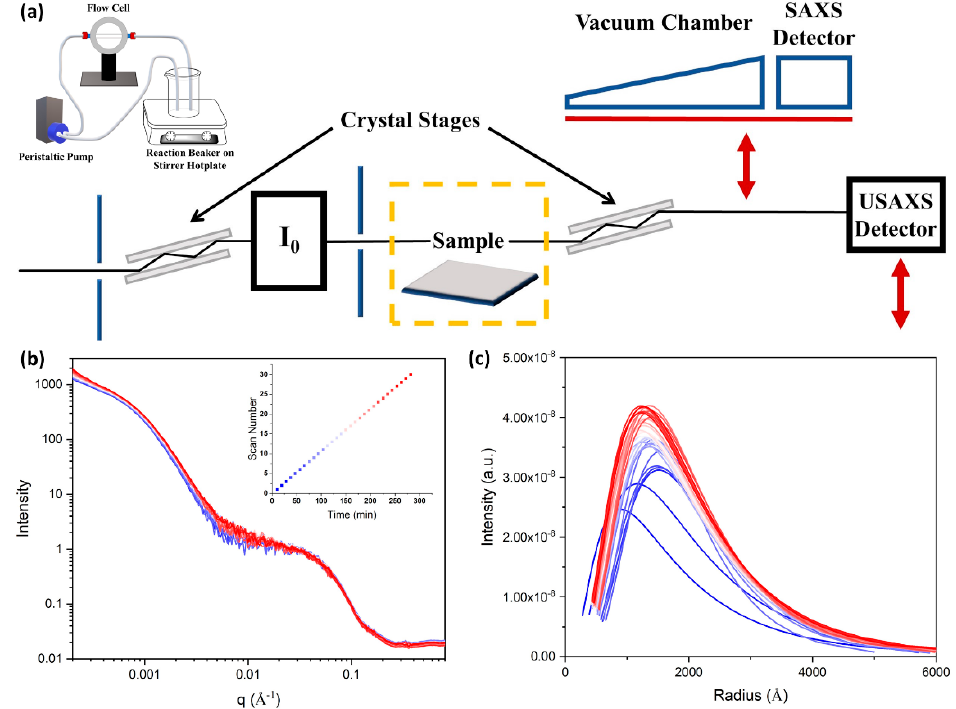
Figure 2. ( a ) Representation of the in situ experimental setup for the flow cell. The red arrows indicate the vertical motion path of the SAXS vacuum chamber and detectors. Blue vertical lines represent beam slits as part of the beamline optics. Black arrows indicate the two crystal stages used for the Bonse-Hart X-ray optics configuration. ( b ) Combined USAXS/SAXS CSNP data as a function of time. ( c ) Lognormal size distribution data from fitting the data in the USAXS range.